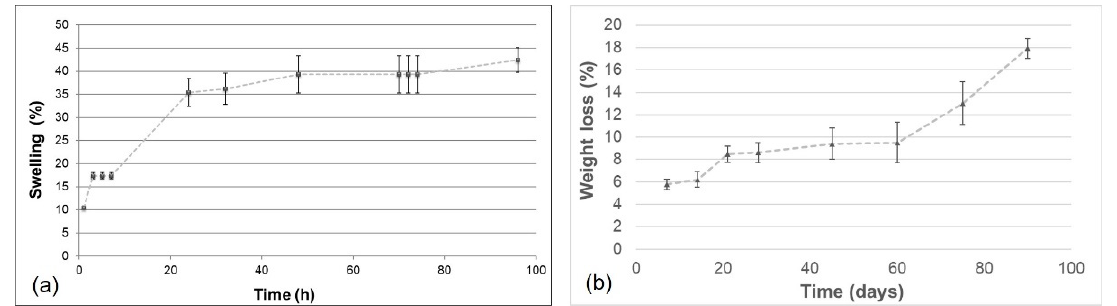
Figure 6. Swelling kinetic for cross-linked GGE scaffold exposed to water vapours ( a ) and weight loss kinetic during the hydrolysis of cross-linked GGE scaffolds ( b ).